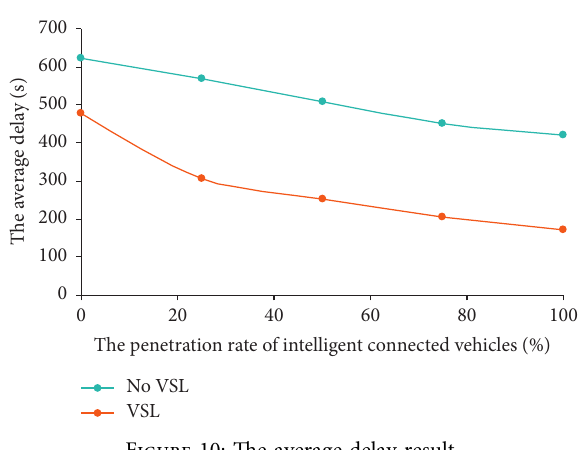
Figure 10: The average delay result.